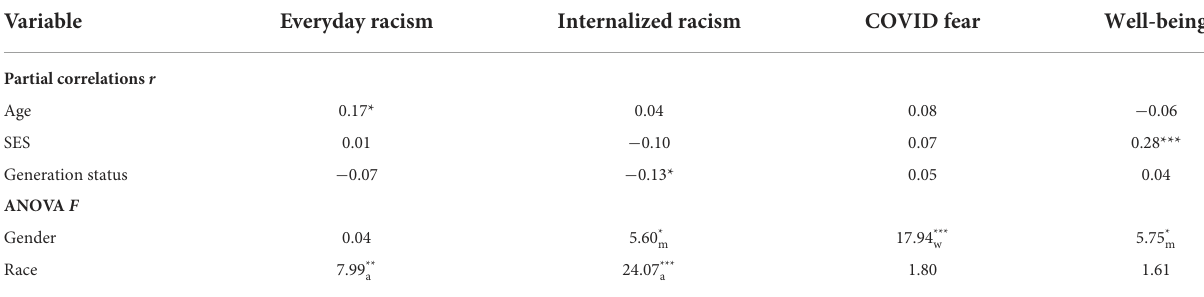
TABLE 2 Correlations and ANOVA results for demographics and study variables for study 1 controlling for everyday racism before the pandemic. Variable